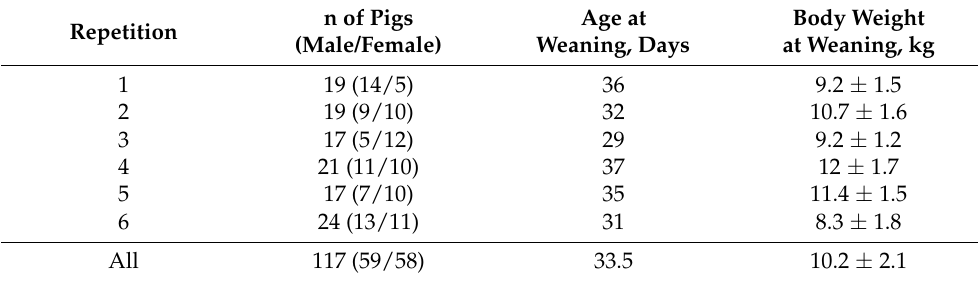
Table 1. Basic litter/piglet characteristics for all six